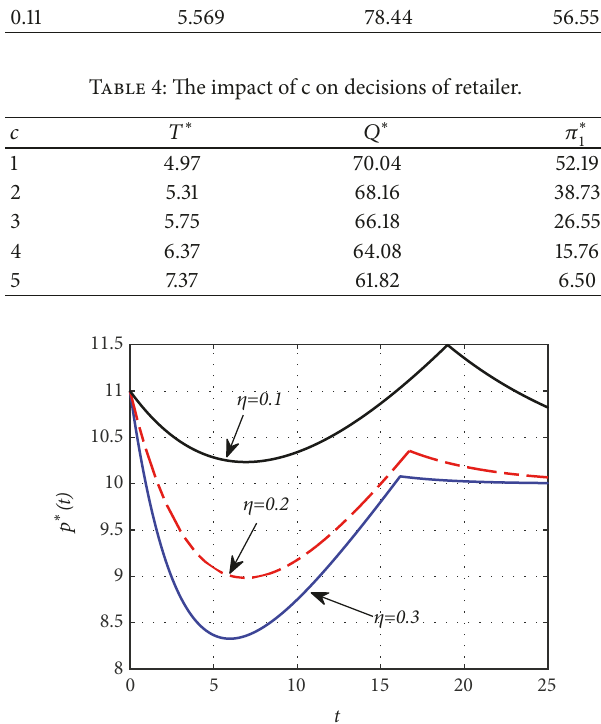
Figure 7: The optimal dynamic pricing strategy with different 𝜂 .